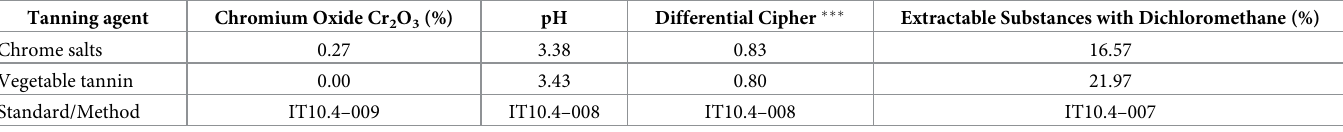
Table 4. Chromium oxide, extractable substances with dichloromethane, pH and differential figure for the paiche ( A . gigas ) leathers tanned with chromium salts and vegetable tannin. Tanning